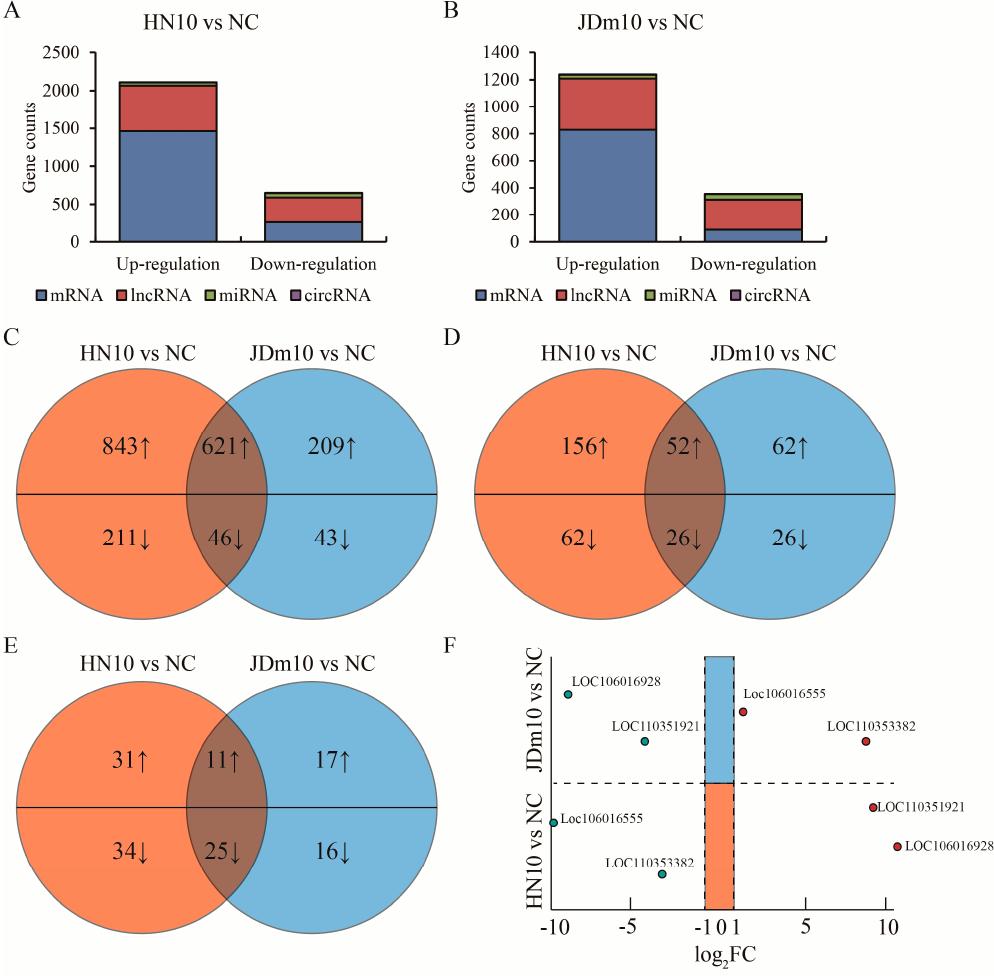
Figure 2. Analysis of mutual DEGs in the bursa of Fabricius induced by HN10 and JDm10. ( A ) Total DEG (|log 2 FC| >1, p < 0.05) counts in the bursa of Fabricius treated with HN10 compared to negative control. ( B ) Total DEG counts in the bursa of Fabricius treated with JDm10 compared to negative control. ( C – E ) Venn diagrams showed the mutual up- or down-regulated mRNA ( C ), lncRNA ( D ) and miRNA ( E ) compared between HN10- and JDm10-induced DEGs. ( F ) Four lncRNAs were listed due to the opposite changes by HN10 and JDm10 treatment compared to negative control.